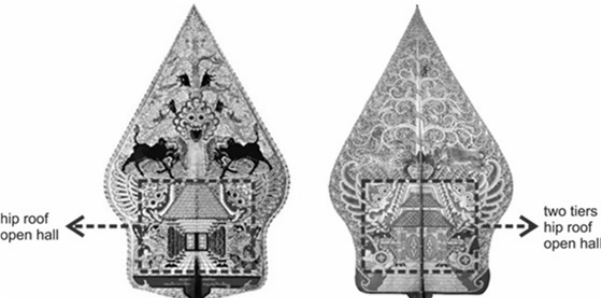
Figure 7. The building type is depicting in the gunungan of the Javanese shadow puppet background: hip roof and double layer hip roof (photos: